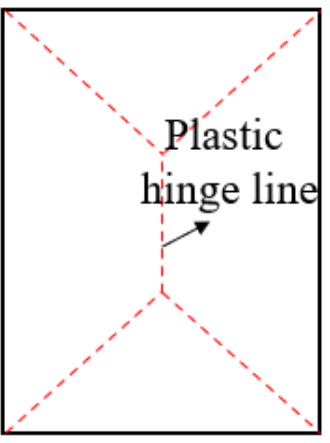
Figure 20. Plastic hinge line in the rectangular plate.